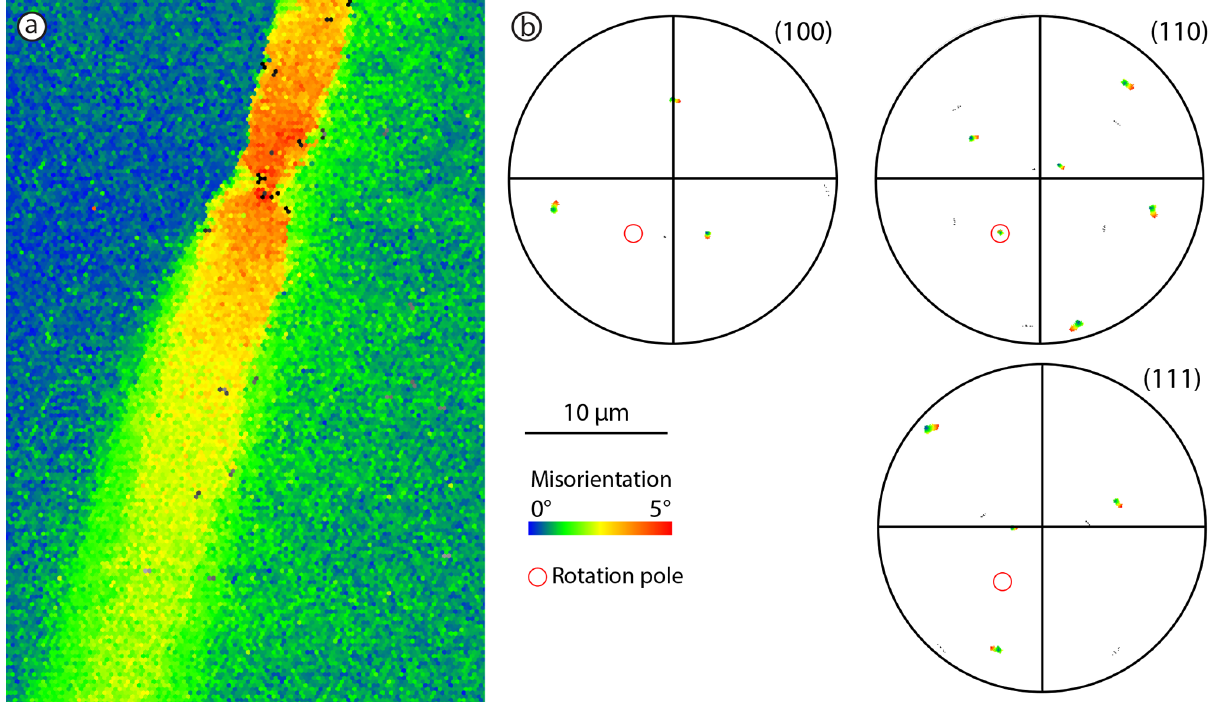
Figure A2. (a) A misorientation map detail for Fig. 6b, with (b) pole figure plots for the garnet axis with the same colour scheme. The plots reveal a rotation around a (101) axis, as indicated by the red